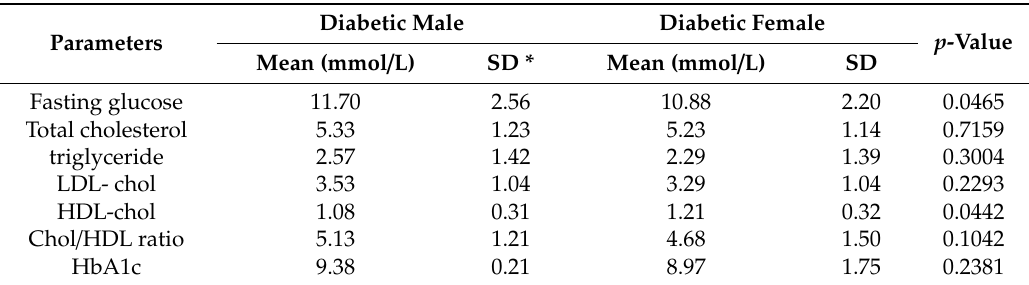
Table 3. Diabetic male and female patients.